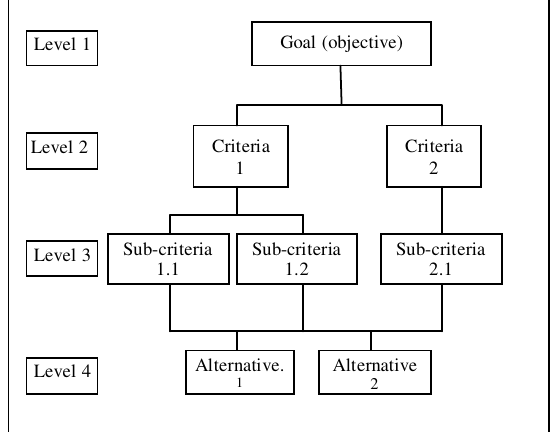
Figure 1 The construct of fuzzy pair-wise comparison